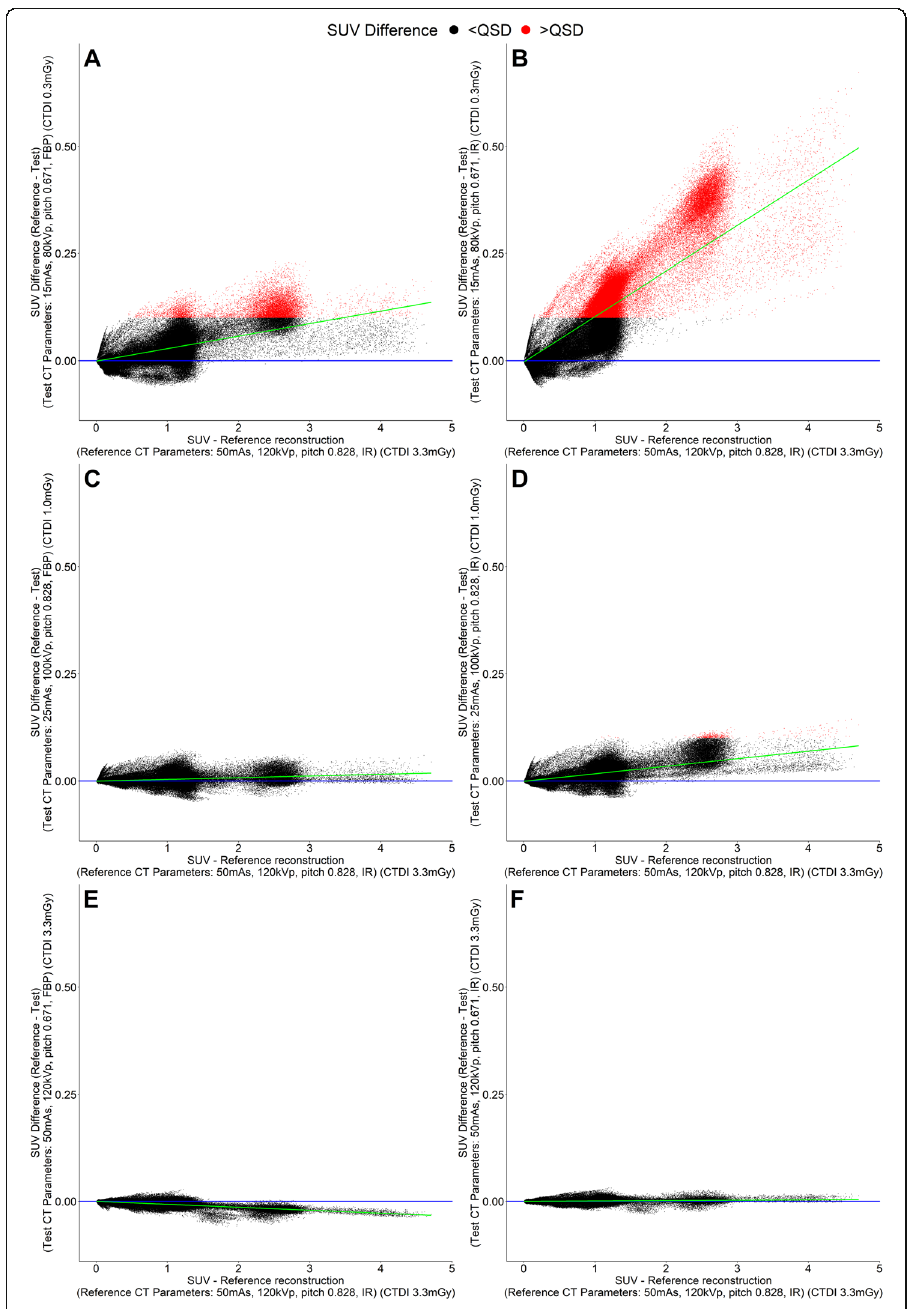
Fig. 4 Graphs of voxel SUV differences between TRs and RR for individual voxels plotted against RR voxel SUV for 3 representative CT acquisition parameter combinations for low (CTDI 0.3 mGy) ( a , b ), medium (CTDI 1.0 mGy) ( c , d ) and high (CTDI 3.3 mGy) ( e , f ) X-ray exposure. CT reconstructed with filtered back projection ( a , c , e ) and iteratively ( b , d , f ). Each dot represents one voxel (black dots are voxels below QSD, and red dots are voxels greater than QSD). The green line is the linear regression fit for difference against reference value, and the blue line is the line of zero